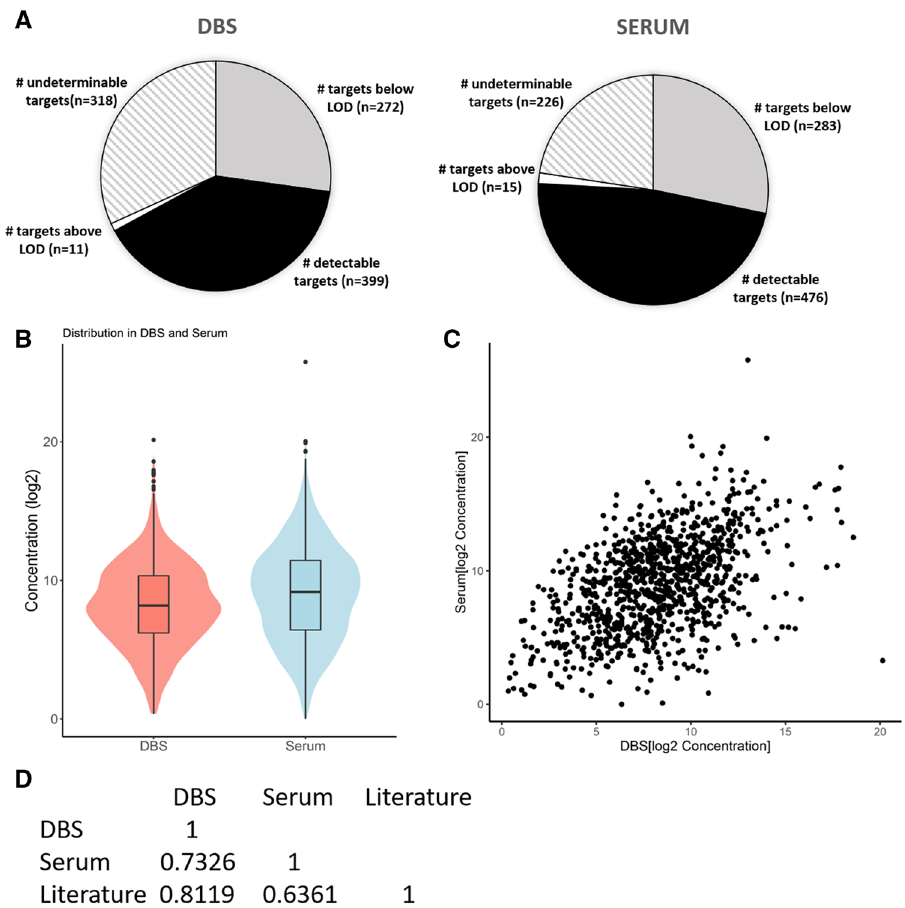
Figure 8. Assessment of measurable proteins in normal DBS and serum samples in a quantitative multi-plex immunoassay. ( A ) Summary of the number of 1000 proteins that are below the LOD, within the detectable range, above the LOD, or that didn’t fall completely in either of the aforementioned categories in at least 2/3 of all samples assessed in DBS and serum, respectively. ( B ) Distribution of the concentration of measurable proteins in DBS and serum samples by violin plot. ( C ) Scatterplot of the distribution of the concentration of measurable proteins in DBS and serum samples. ( D ) Correlation of the 18 DBS and 28 Serum measurable FDA- approved protein biomarkers in at least 2/3 of the 72 DBS and 200 serum samples assessed with each other and reported serum literature values.